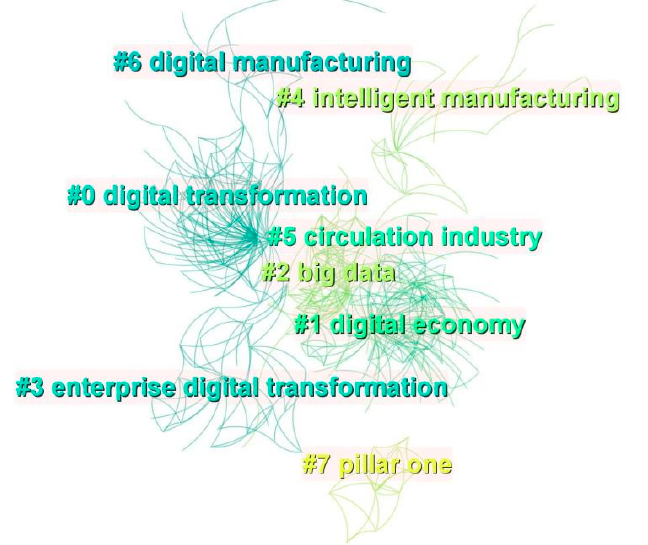
Figure 2. Co-occurrence map of research keywords in the field of enterprise digitalization from 2002 to 2021.